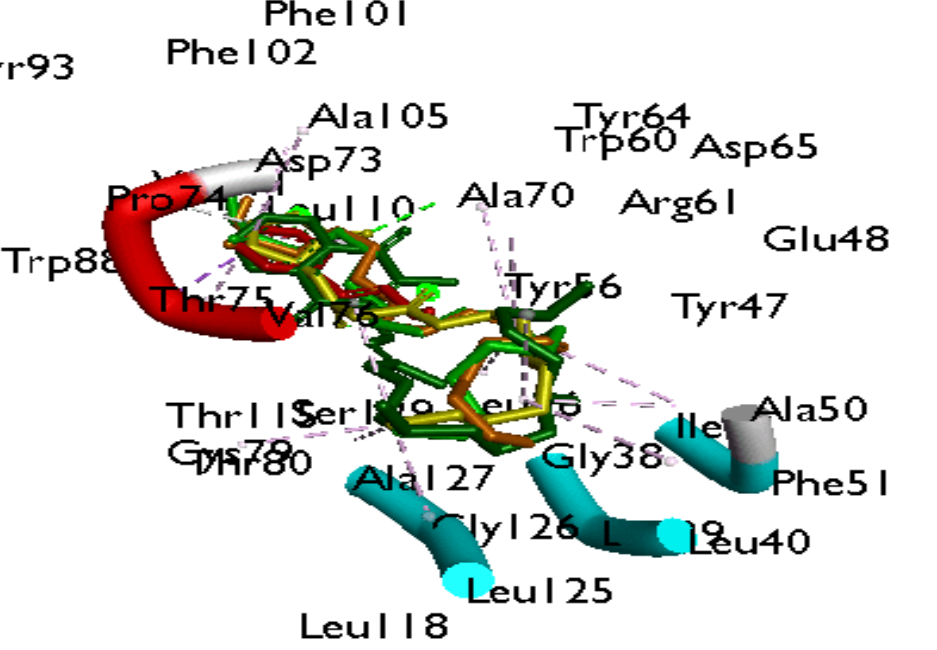
Figure 9. Superimposition of docked compounds on co-crystal structure of LasR (RMSD: 0.5 Å): Red: native inhibitor, Brown: standard drug (Cinnamaldehyde), Yellow: standard drug (Azithromycin), and Green: ligand with the highest binding affinity (Phylloquinone).